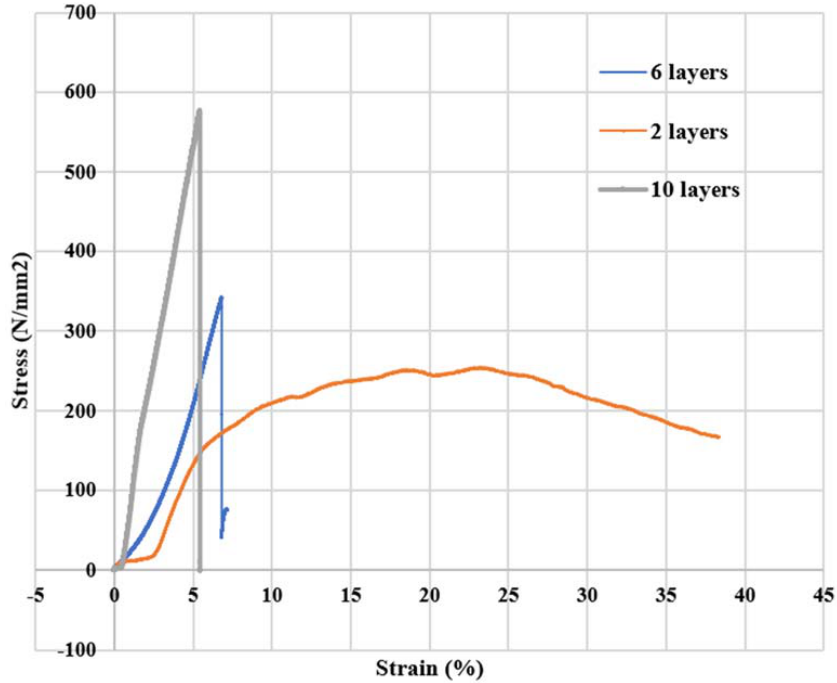
Figure 7. Stress–strain Superimposed scattered plot for tested carbon-fiber samples.